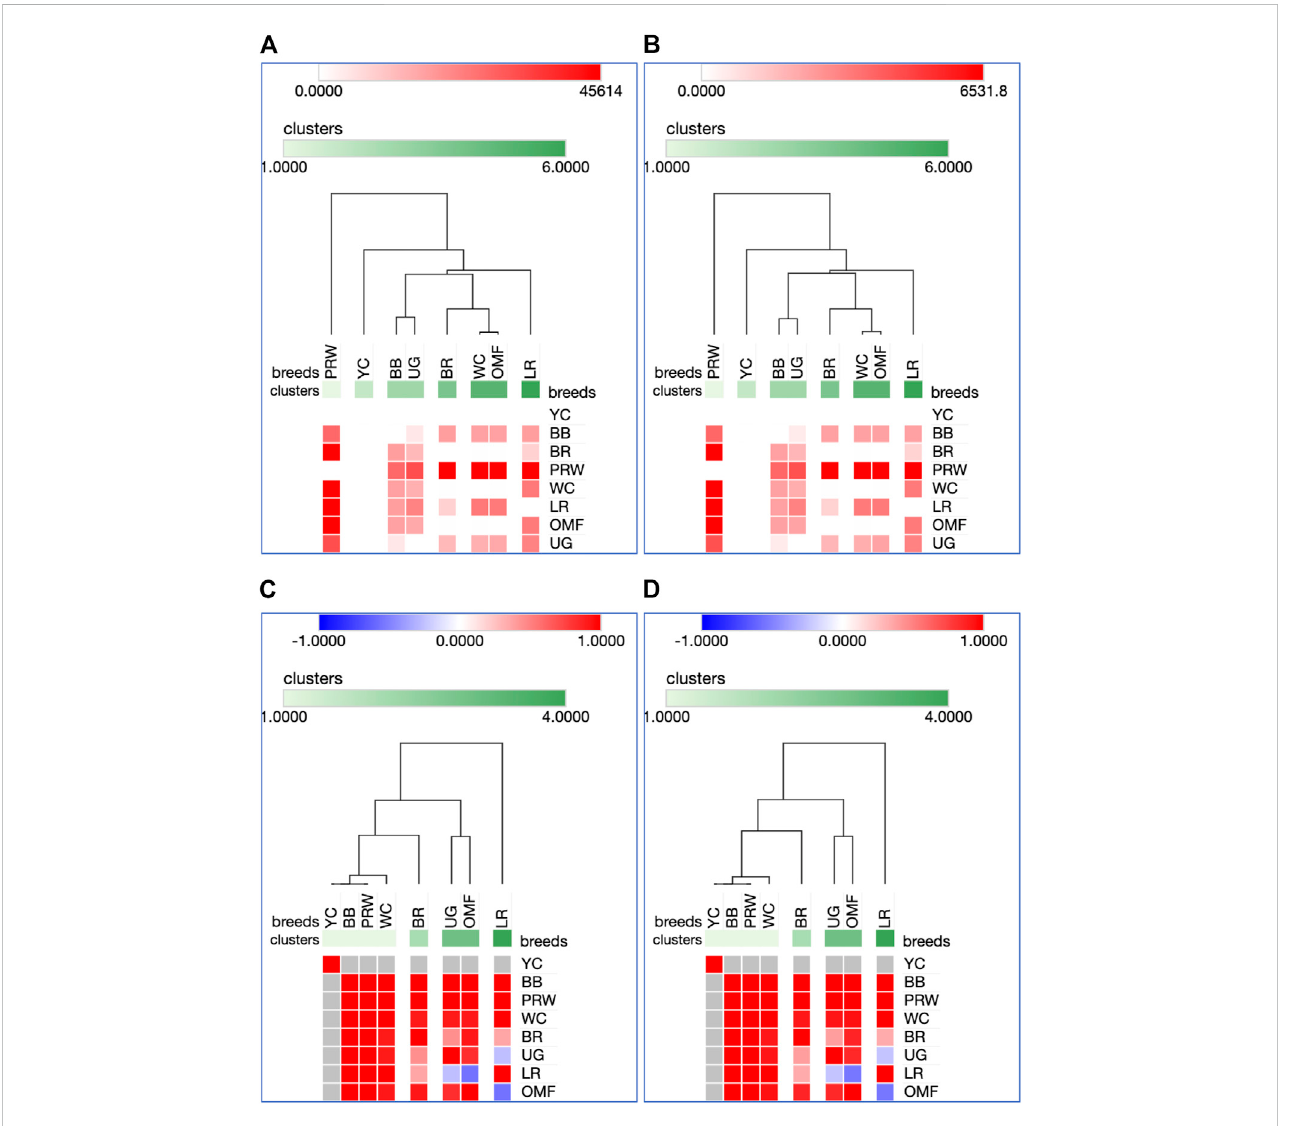
FIGURE 5 Heatmaps and hierarchical clustering trees based on Euclidean distance metric (with the average option selected for the linkage method) and using the Type IIIa (A,C) and IIIb (B,D) data as inferred for the eight studied breeds and seven tested myogenesis associated genes expressed in the breast muscles. For constructing the trees, precomputed similarity matrices were built using Euclidean distance (A,B) and Pearson correlation (C,D) as